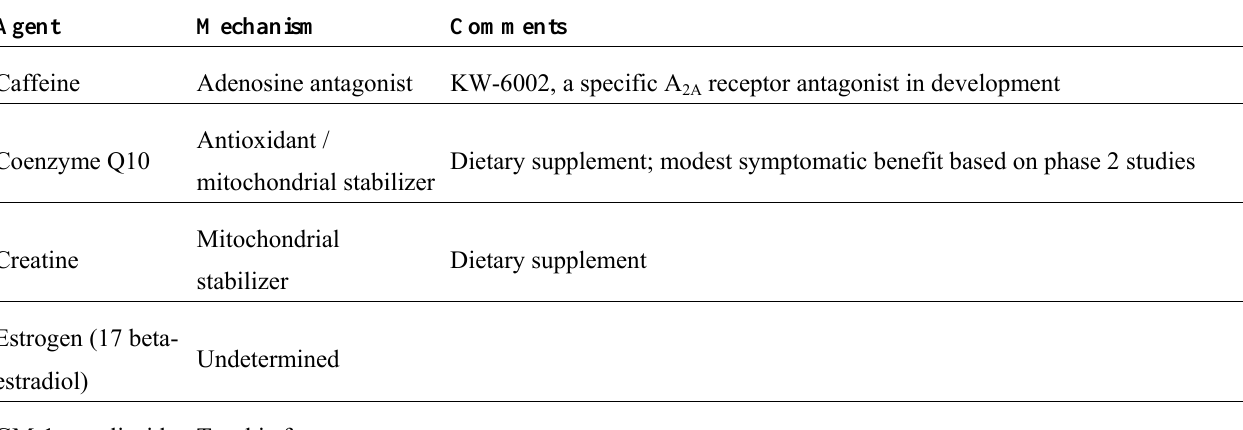
Table 2. Drugs accepted by